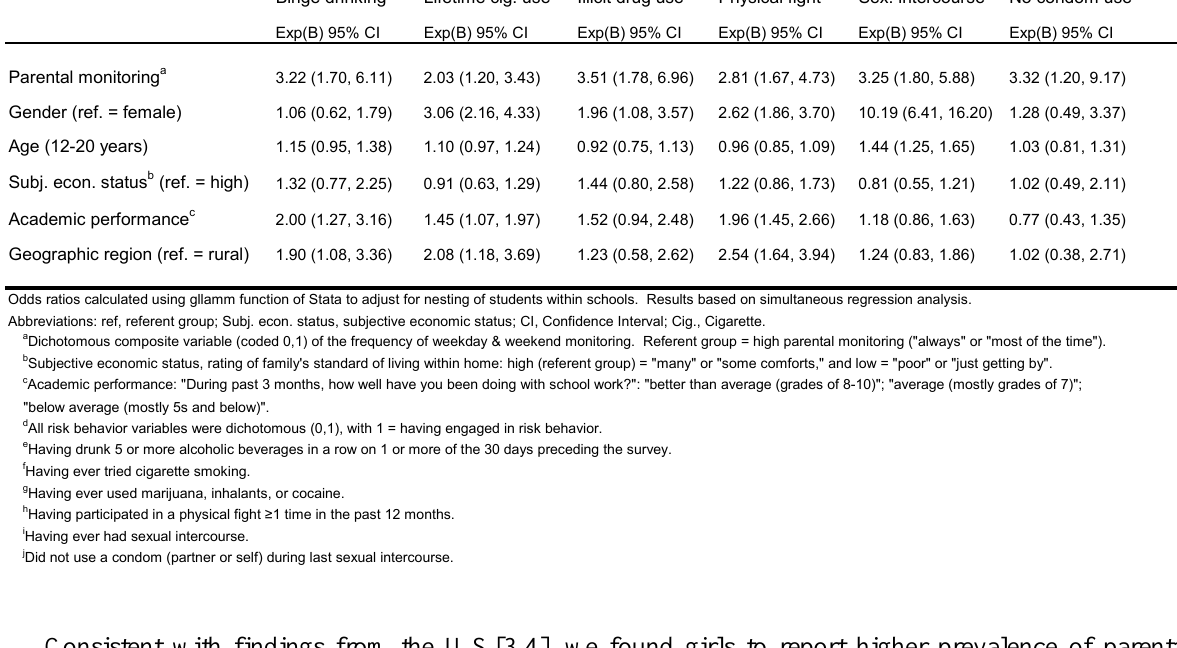
Table 2. Odds ratios for selected health risk behaviors by perceived parental monitoring in public secondary school students from central El Salvador, adjusted for socio-demographic variables, 1999. ( n = 935) Binge drinking d,e Lifetime cig. use d,f Illicit drug use d,g Physical fight d,h Sex. intercourse d,i No condom use